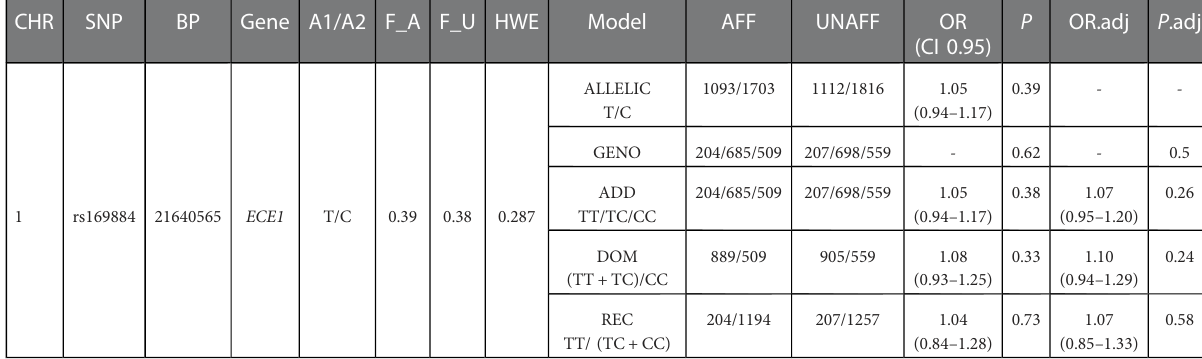
TABLE 2 Results of SNP rs160844 in a southern Chinese population of 1,470 cases and 1,473 controls.